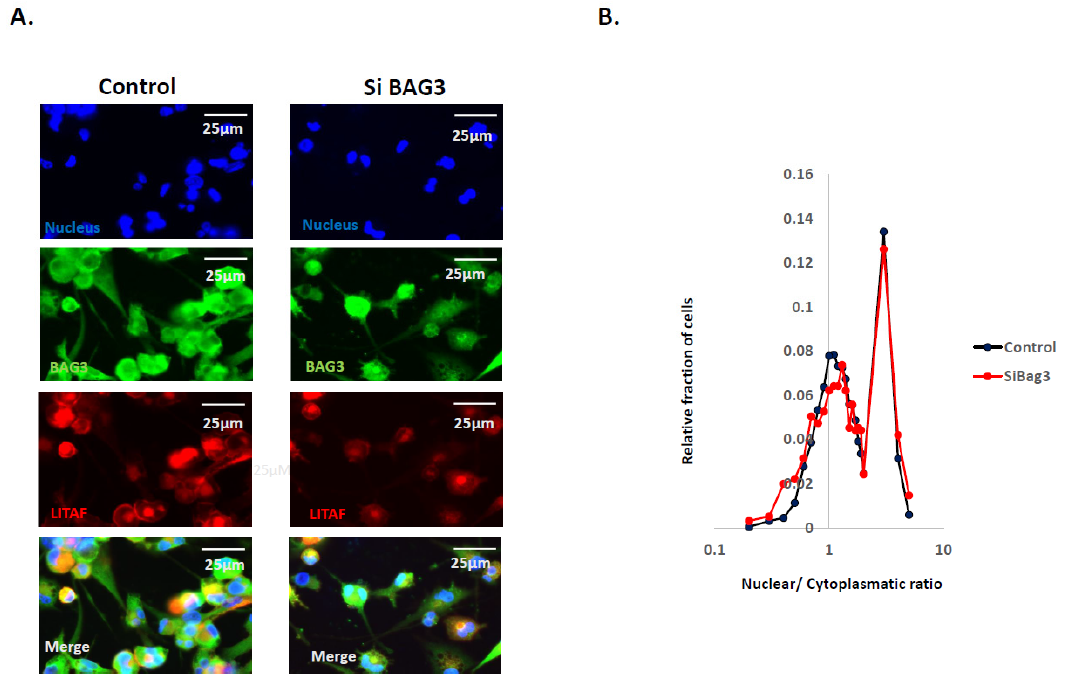
Figure 2. Effect of BAG3 on nuclear localization of LITAF. ( A ) Representative image of localization of LITAF in control and BAG3-silenced differentiated THP1 cells (images are representative of three experiments). ( B ) Distribution of cells in the population according to the N/C ratio (nuclear/cytoplasmatic) of LITAF in control cells and BAG3 silenced cells. Cells were treated on 96-well plates and fixed, and the localization of LITAF was assessed by immunofluorescence. Image acquisition and analysis were performed using the Hermes imaging system. Although LITAF levels were affected by the silencing of BAG3, the nuclear/cytoplasmatic ratio remained the same in control and BAG3 silenced cells.